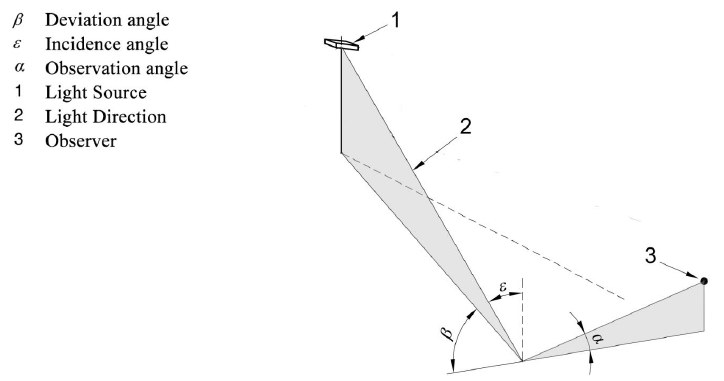
Figure 1. Relevant angles in road lighting